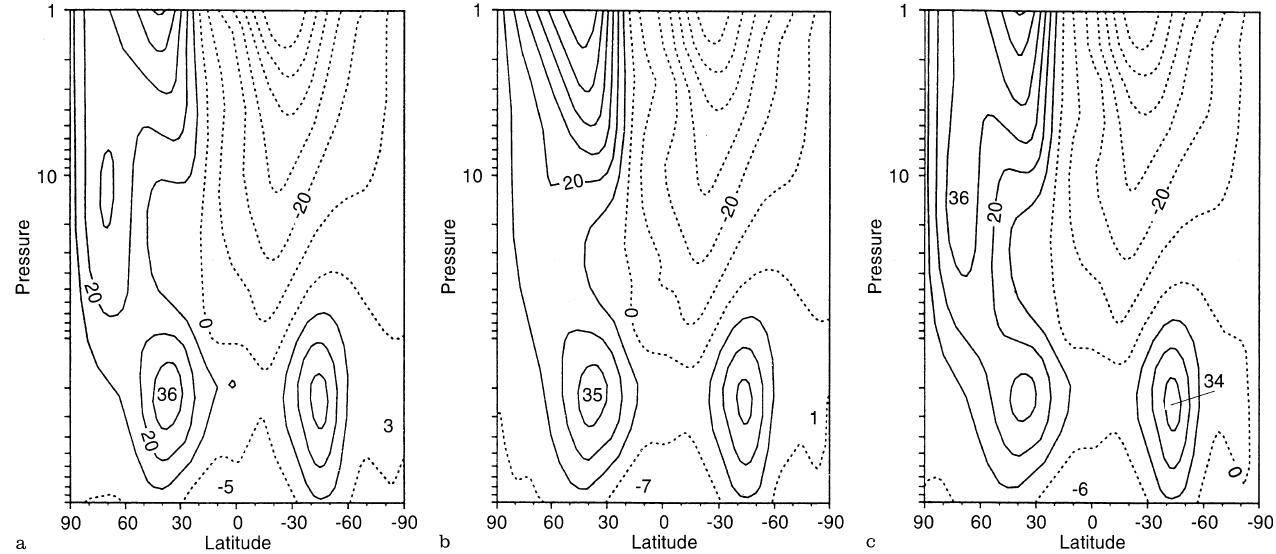
Fig. 10a–c. Zonal average of zonal wind in m s (cid:255) 1 for January for a GWD31, b GWDS41 and c GWDT41; contour interval 10 m s (cid:255) 1